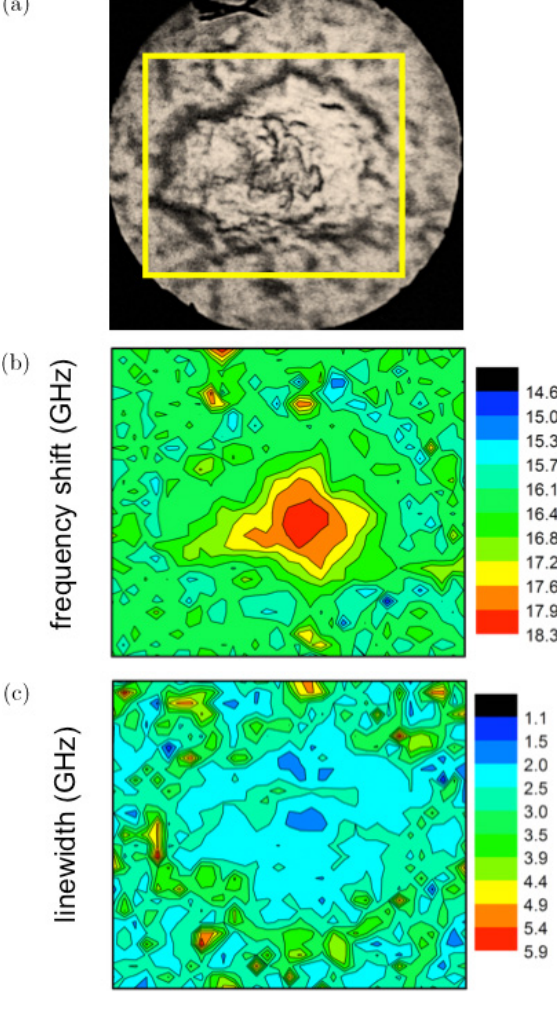
Fig. 8. (Color online) (a) Photomicrograph of a TASTPM mouse brain hippocampal section containing a single plaque collected with the Brillouin microscope in re°ection mode using a 20 (cid:1) objective. (Yellow box denotes a 66 (cid:1) 60 (cid:2) m 2 area where a Brillouin map was acquired using a 1.5 (cid:2) m step-size). Maps based on the (b) frequency shift and (c) linewidth of the Bril- louin peak derived from ¯t analysis of the spectra in the map. Red color region in (b) denotes the plaque core, whilst in (c) it denotes the lipid-loaded ring surrounding the